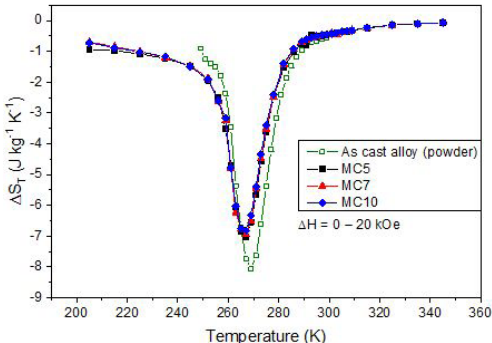
) at a magnetic field T Ge Si powder, MC5, 5.09 2.03 1.88